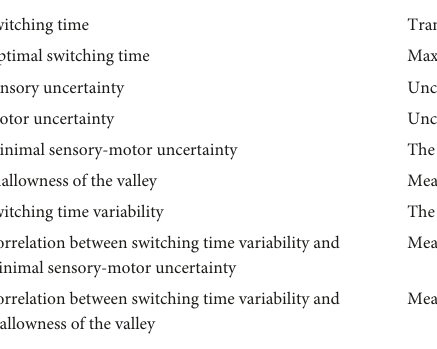
TABLE 1 Summary of behavioral and model derived measures.